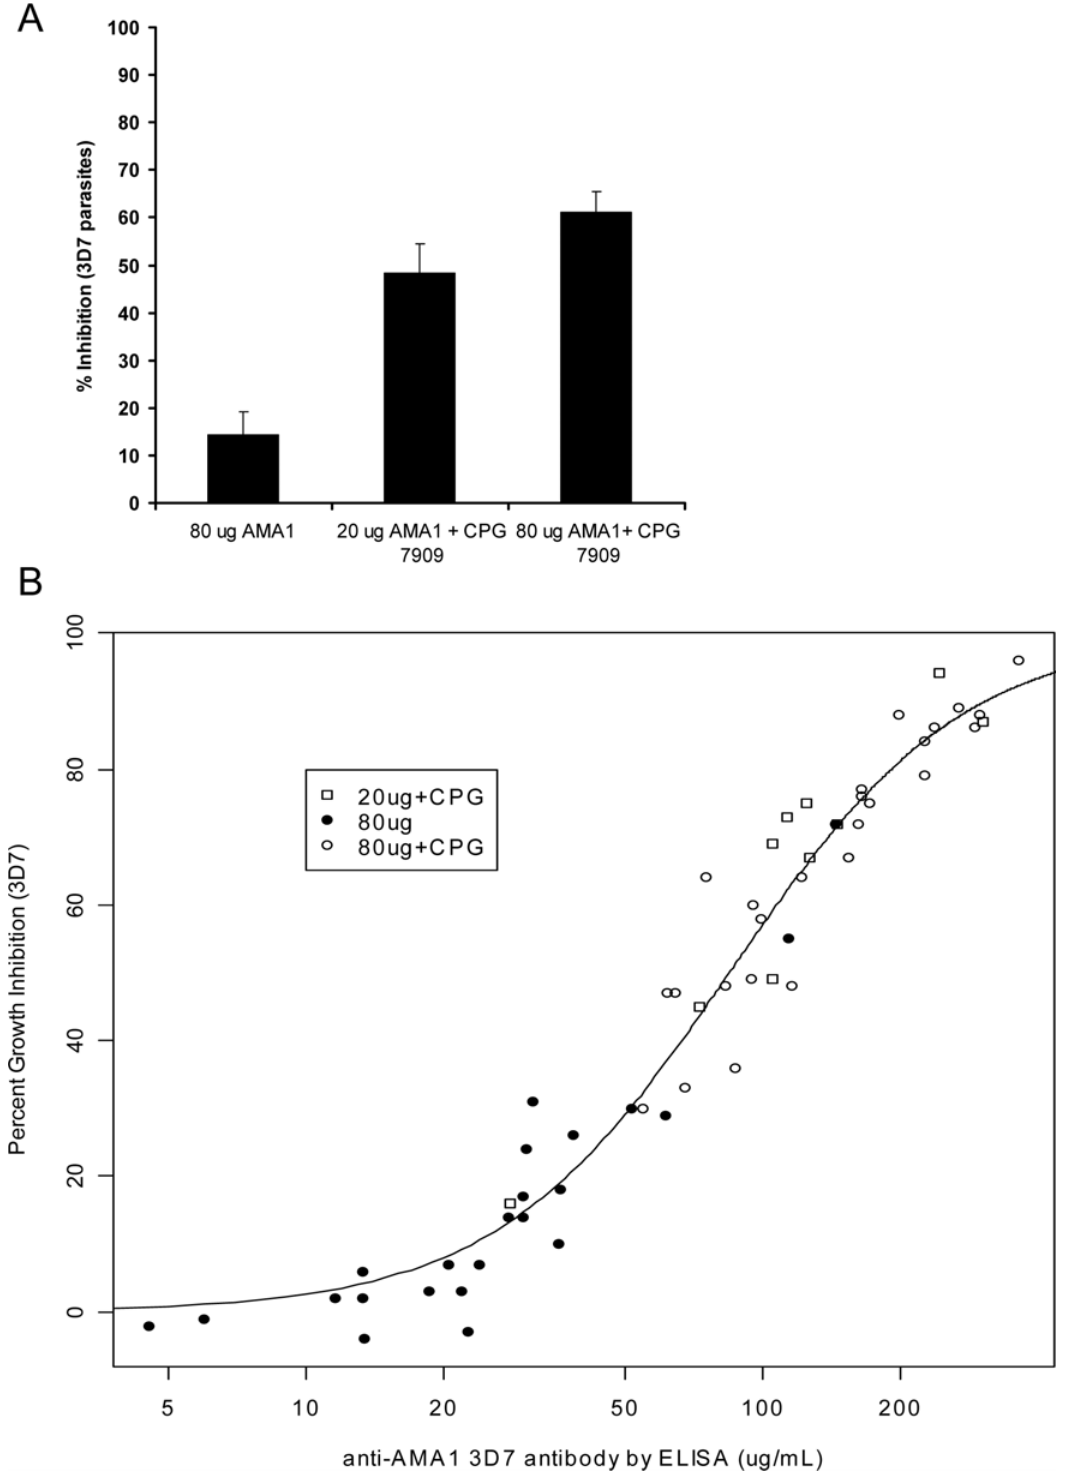
Figure 4. Functional Immunological response: Homologous in vitro parasite growth inhibition in recipients of the 20 or 80 m g AMA1-C1/Alhydrogel 6 CPG 7909 vaccines. Day 70 in vitro parasite growth inhibition response against 3D7 parasites measured by GIA using total IgG purified from individual sera. (A) Arithmetic mean of % inhibition against 3D7 parasites is shown with standard error bars. (B) The concentration of Day 70 AMA1-specific antibody ( m g/mL) to test wells (x-axis) is plotted against % inhibition (y-axis). The individual data points represent 80 m g AMA1 (black circles, n =23), 20 m g AMA1 + CPG (white squares, n =10), and 80 m g AMA1 + CPG (white circles, n =25).